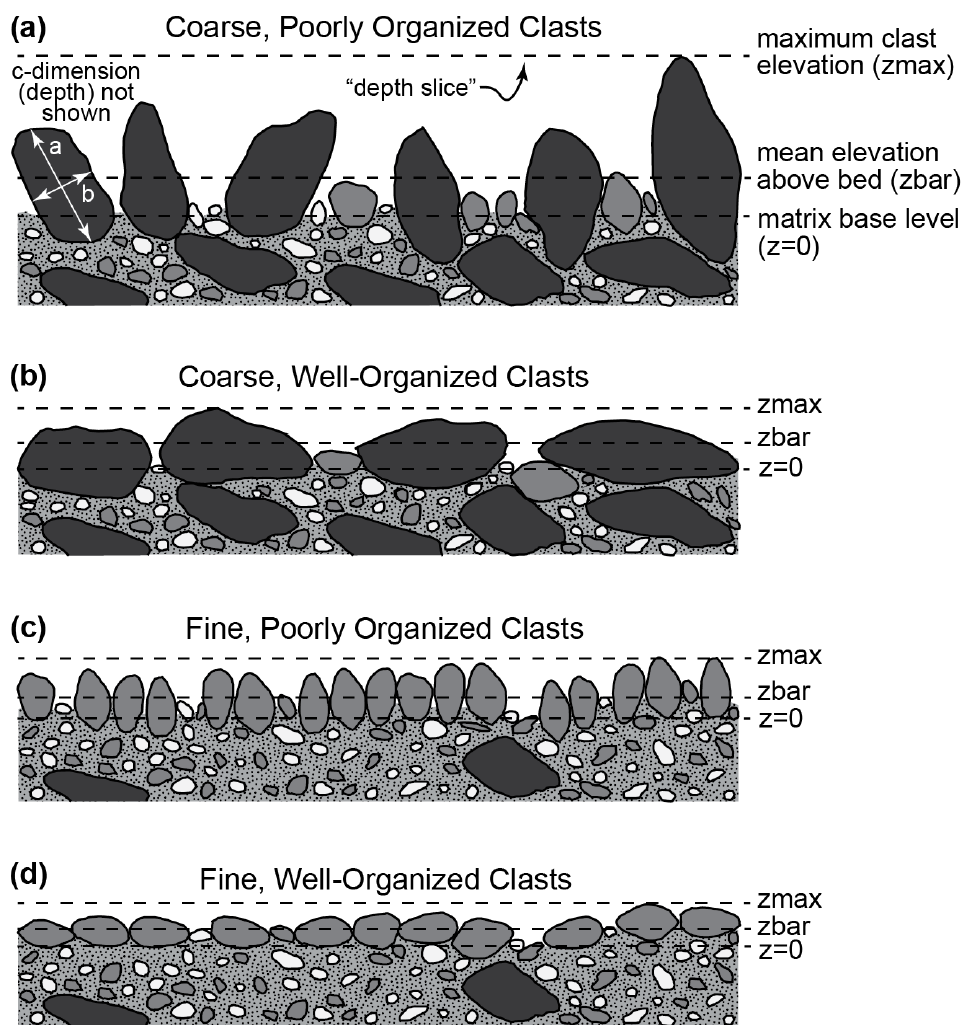
Figure 4. Conceptual framework of organization in heterogenous beach sediments with relatively coarser and finer surficial clasts. Conceptualized examples are shown for ( a ) relatively coarse- grained, poorly organized surficial clasts; ( b ) relatively coarse-grained, well-organized surficial clasts; ( c ) relatively fine-grained, poorly organized surficial clasts; and ( d ) relatively fine-grained, well-organized clasts;